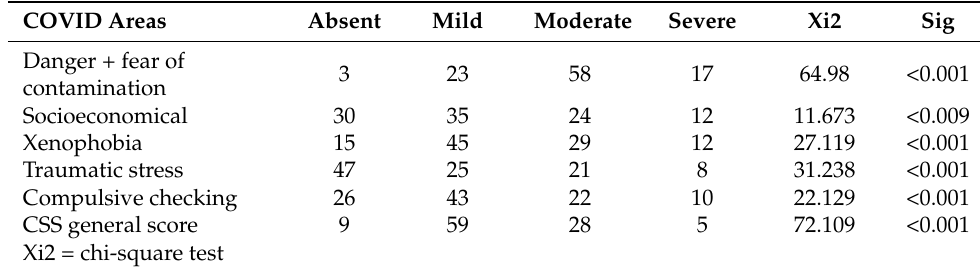
Table 3. Analysis per general area.